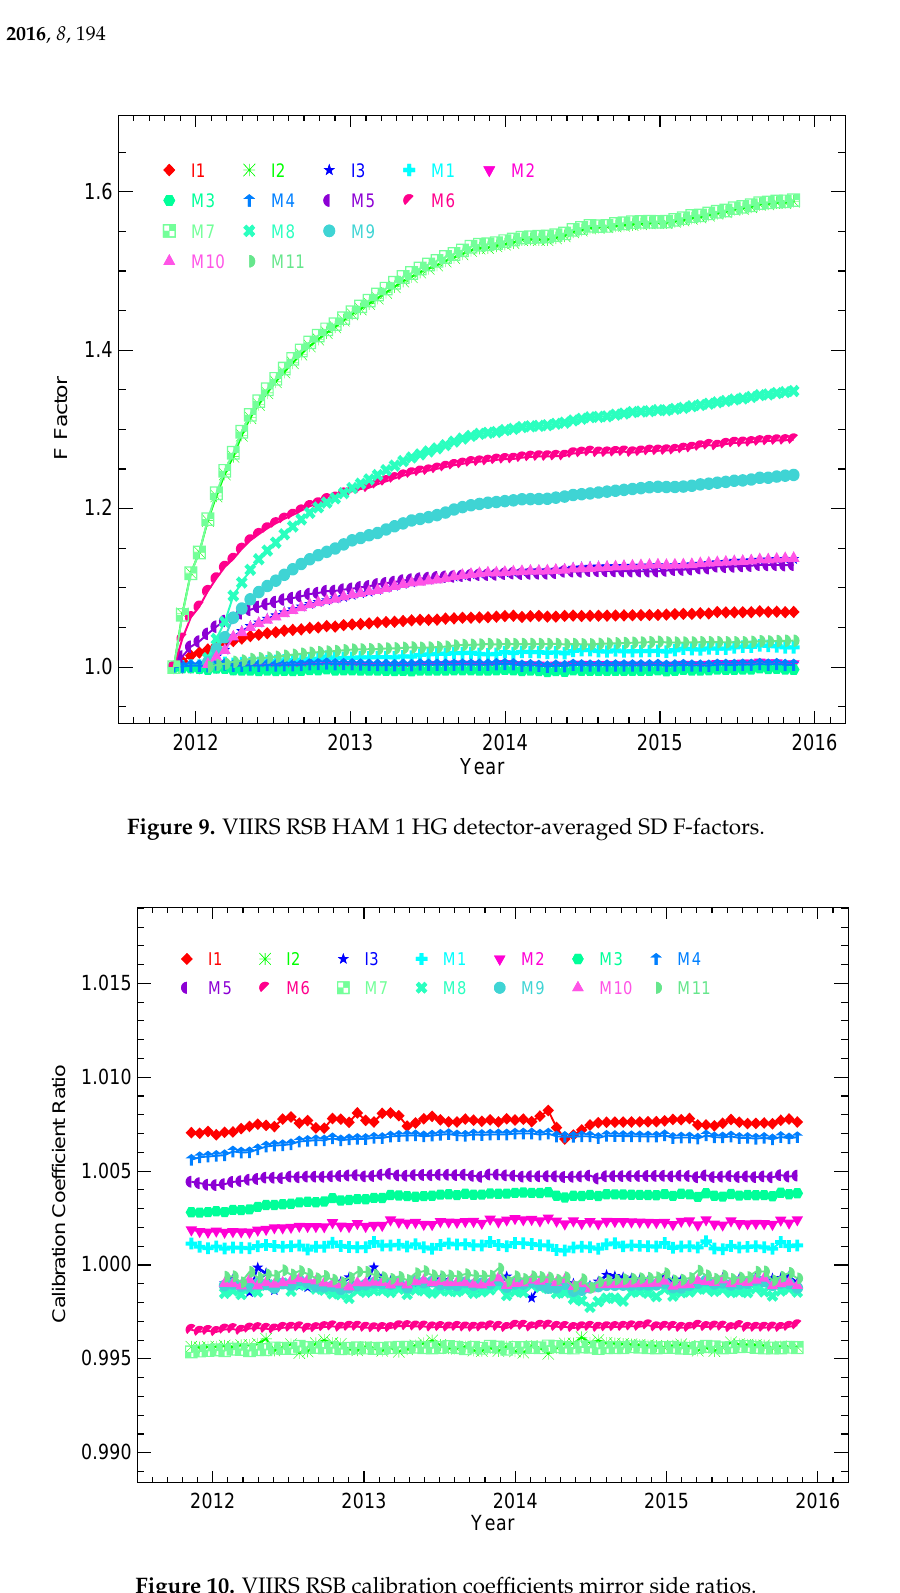
Figure 10. VIIRS RSB calibration coefficients mirror side ratios.